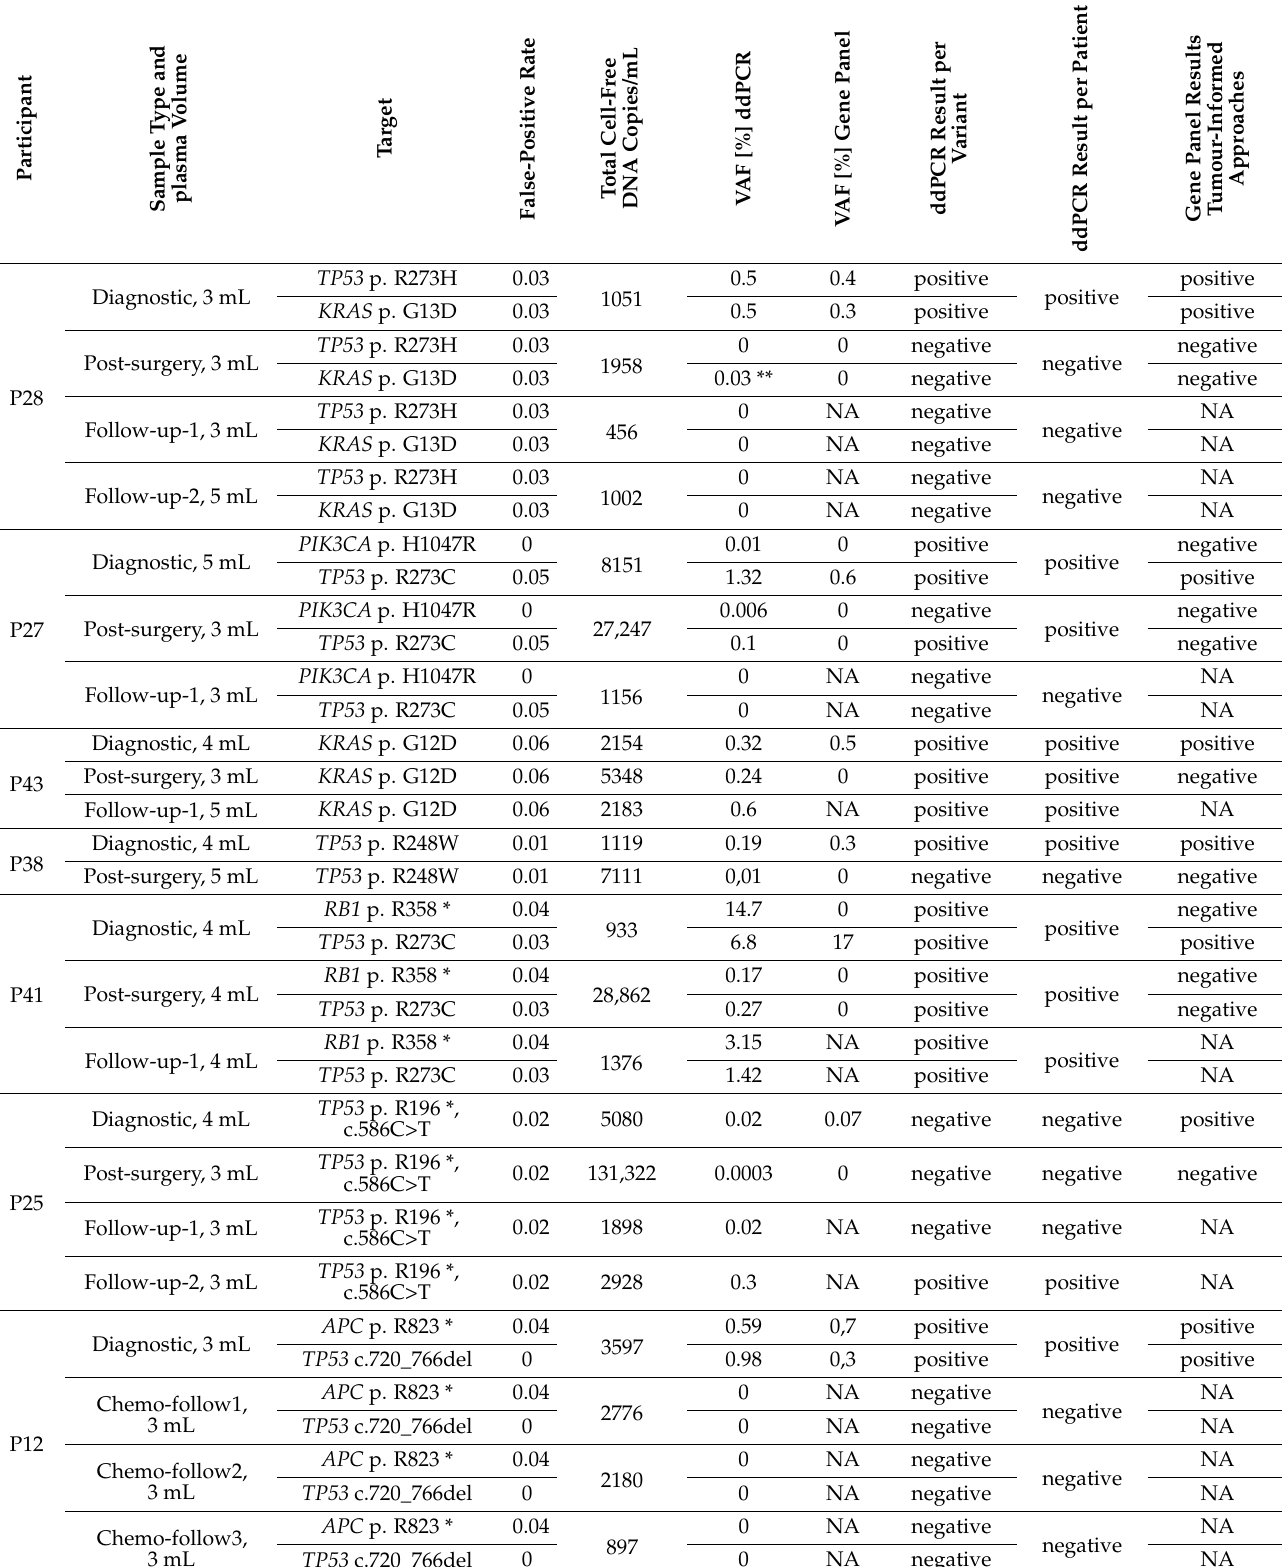
Table 3. Longitudinal cell-free DNA analysis using ddPCR, including input